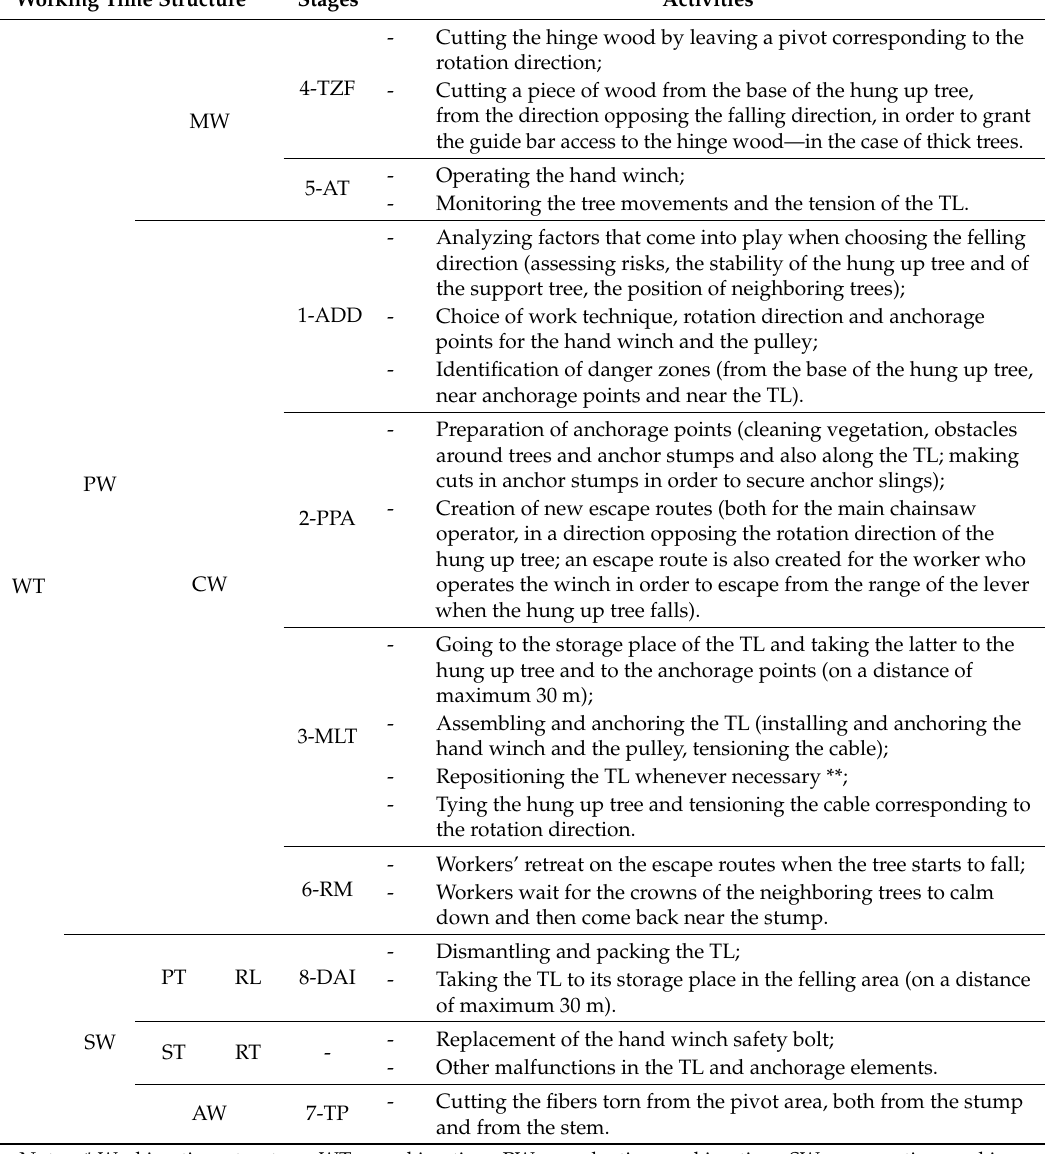
Table 3. Working time structure in the felling of hung up trees (adapted from